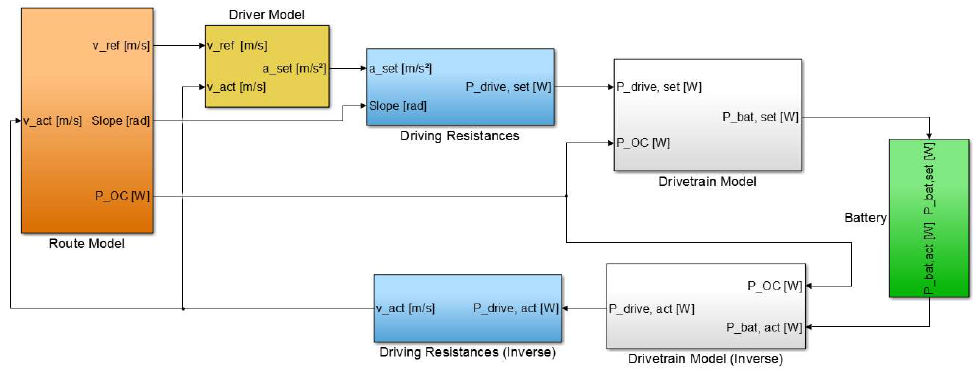
Figure 2. Overview of the vehicle simulation model.